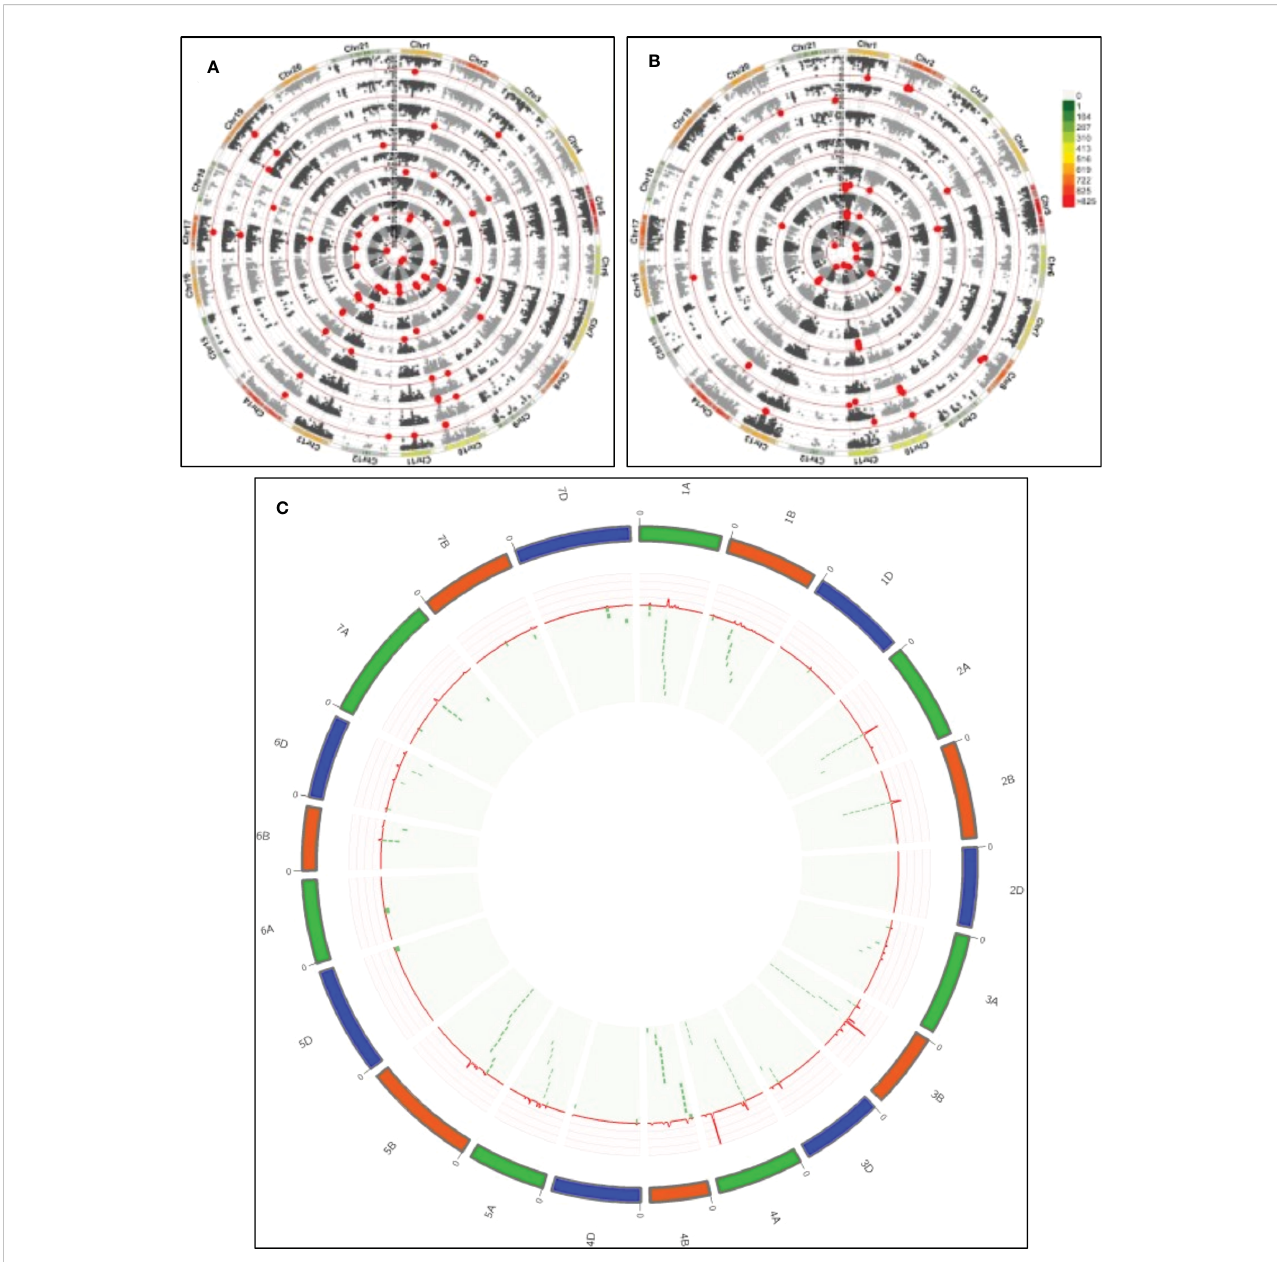
FIGURE 3 QTL detection for quality and agronomic traits. (A) From inside out, GWAS for P/L, W, FP, FS, GP, LV, MT, P. (B) From inside out, GWAS for GFD, FY, GFR, TKW, TW, GY, GH. The colour bar indicates the density of SNP markers along the chromosomes. Red dots indicate signi fi cant MTAs (-log P>3). (C) QTL overview index. The index values (peaks) are represented along chromosomes as a red line. Green dashed tiles represent the signi fi cant MTAs below the QTL overview